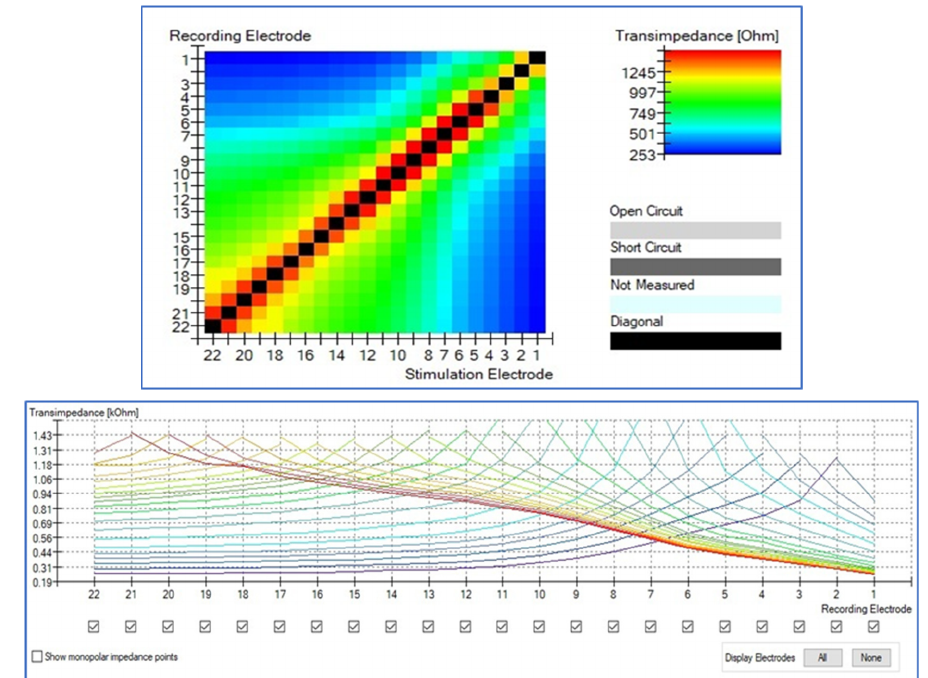
Figure 6. Typical transimpedance measurement result. The intracochlear voltage drops monotonically as the distance between stimulation and recording contact increases, both toward the apex and toward the base, in perimodiolar electrode cases (CI622). HEAT map and Line graph are presented. Higher impedances are observed.